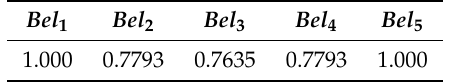
Table 2. Failure credibility Beli of each